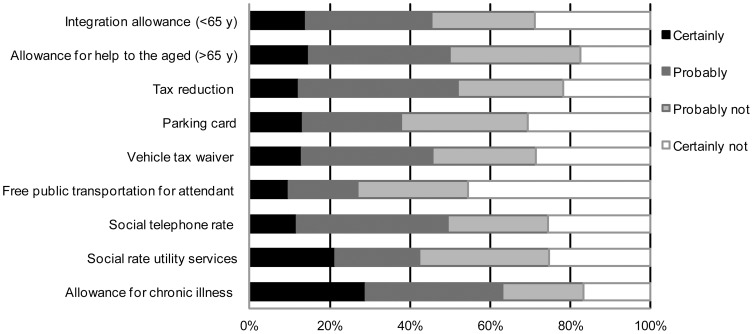
Assessment of need for social support measures by the rheumatologist.Data are expressed as percentage of patients. For support measures with age limits, the patient percentage refers only to the patients in the age category eligible to receive the benefit.